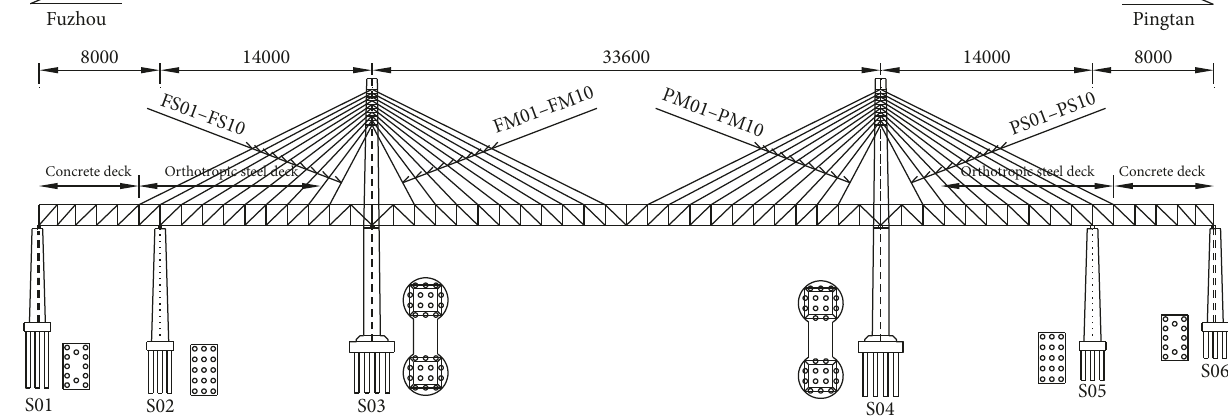
Figure 3: The elevation layout of Daxiao Liandao waterway bridge (unit: cm).